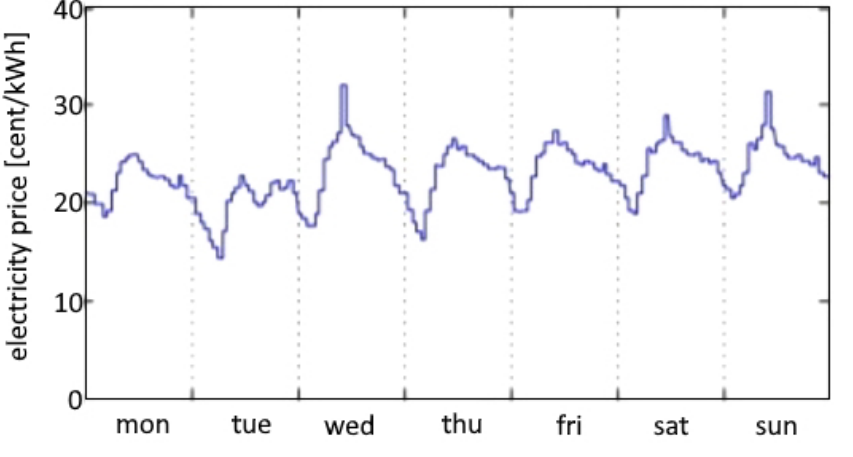
Figure 5. Changes in energy price over time